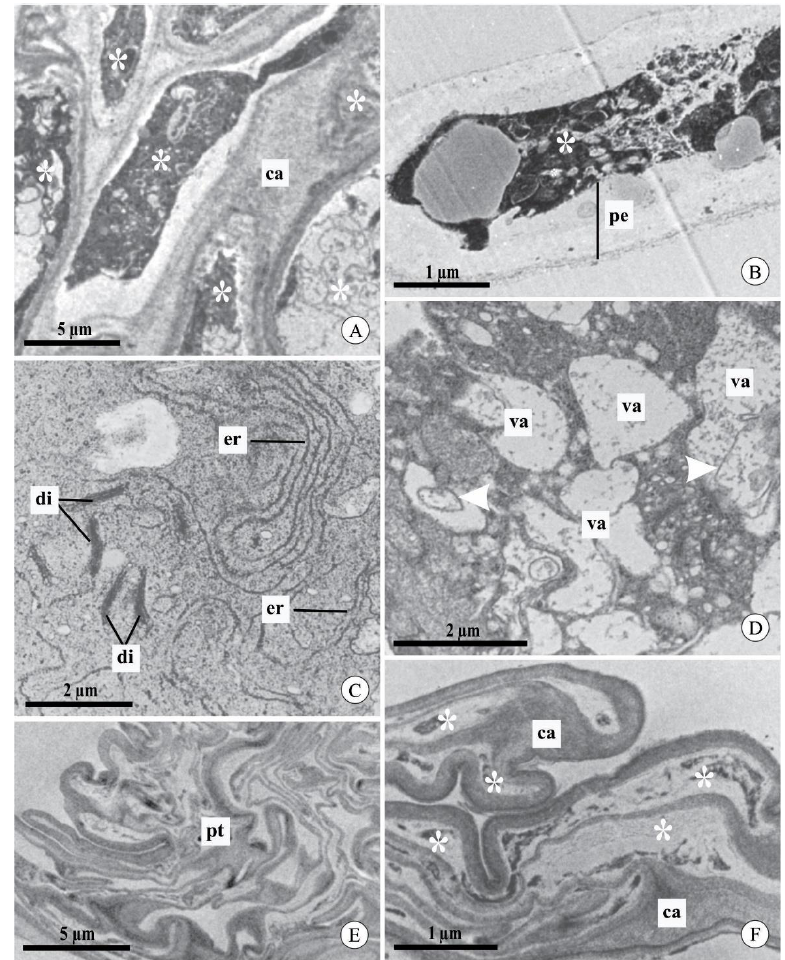
Figure 5. Pollen tubes in the stylar canal inside the column and seed chamber of fruits of Acianthera johannensis ( A , C – F ) and A. fabiobarrosii ( B ), after experimental self-pollination, using transmission electron microscopy. ( A ) Pollen tubes with the cytoplasm (asterisks) in a degeneration process (7 days after pollination-DAP), evidenced by the high electron density. ( B ) Pollen tube (9 DAP) with large periplasmic space and degenerated cytoplasm (asterisk). ( C ) Detail of a pollen tube with endoplasmic reticulum with dilated membranes and dictyosomes in the degeneration process (7 DAP). ( D ) Pollen tube with cytoplasm in the degeneration process. Note the presence of vacuoles with an irregular contour and flocculated content with internal membranes (arrowheads). ( E , F ) Pollen tubes in the seed chamber of mature fruit (90 DAP). In ( F ), notice the degenerated cytoplasm (asterisks) and the deposition of callose plugs. ca, callose. di, dictyosome. er, endoplasmic reticulum. pe, periplasmic space. pt, pollen tube. va, vacuole.